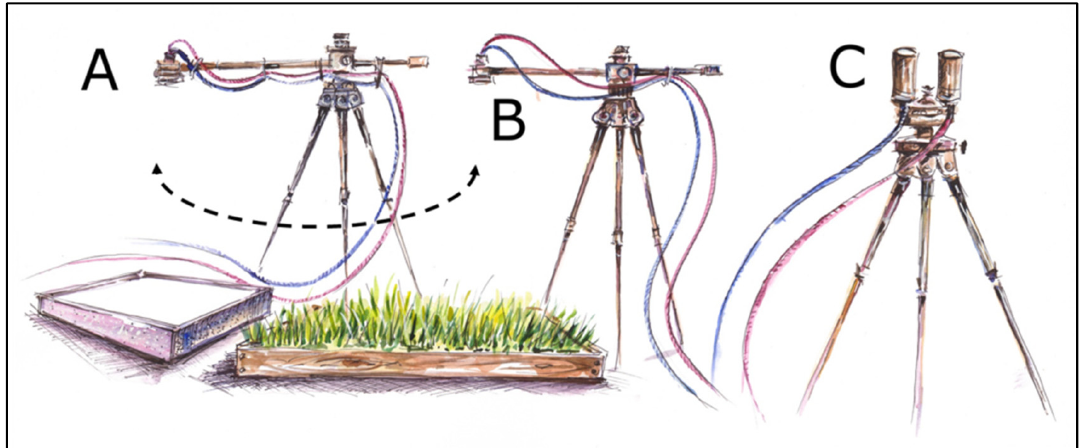
Figure 1. Experimental field setup: ( A ) The fiber optics connected to ASD Filedspec Pro and QE Pro spectroradiometers are secured to a rotating arm allowing the alternating movement from the white reference panel and the vegetation target; ( B ) The S-FLUO box downward channels (both HR4000 Narrow Range and HR4000 Full Range) are attached to a fixed tripod looking at the vegetation; ( C ) S-FLUO box upward channels are horizontally mounted on the third tripod to collect reference measurements.